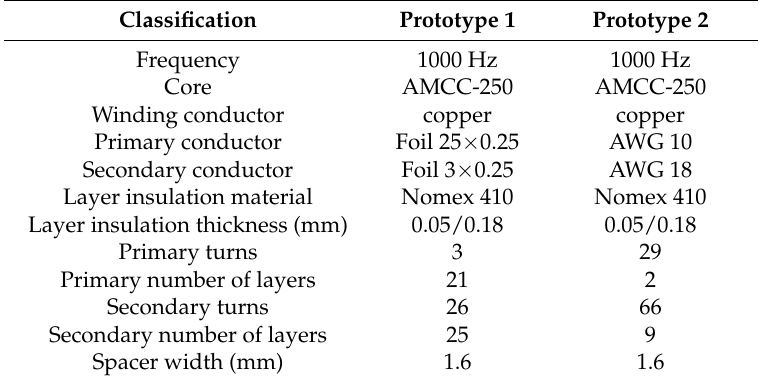
Table 3. Specifications of transformer